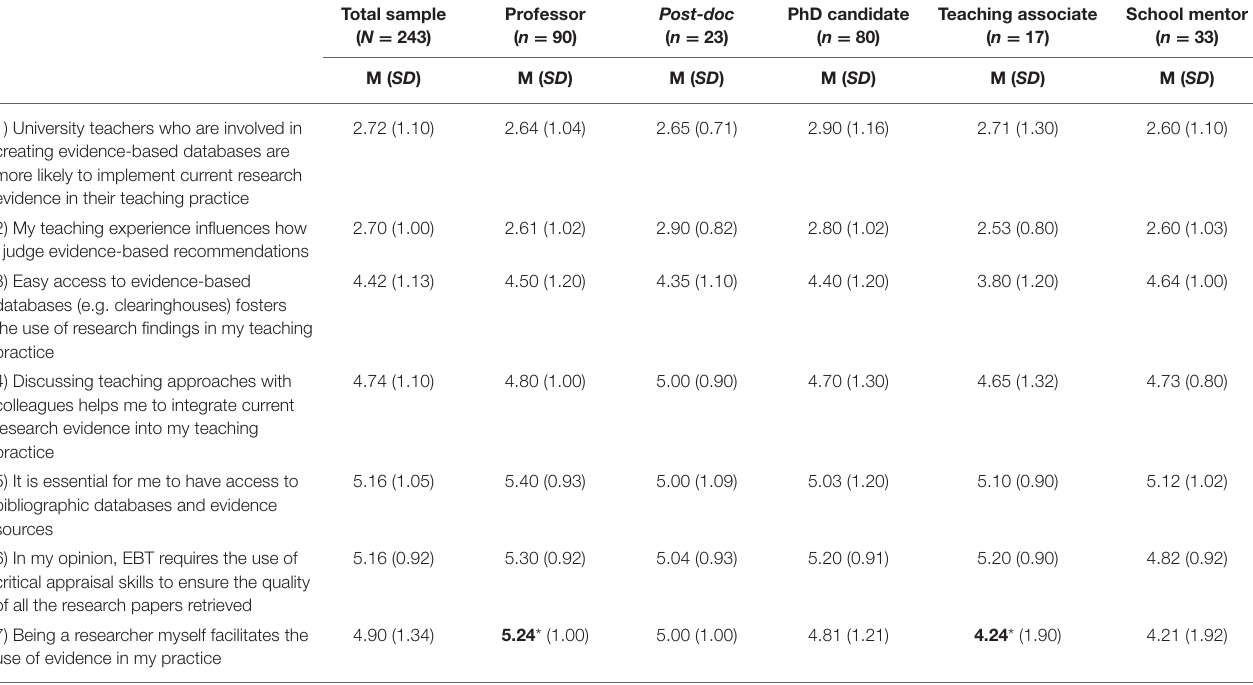
TABLE 5 | Teacher educators’ perceived facilitators to foster EBT